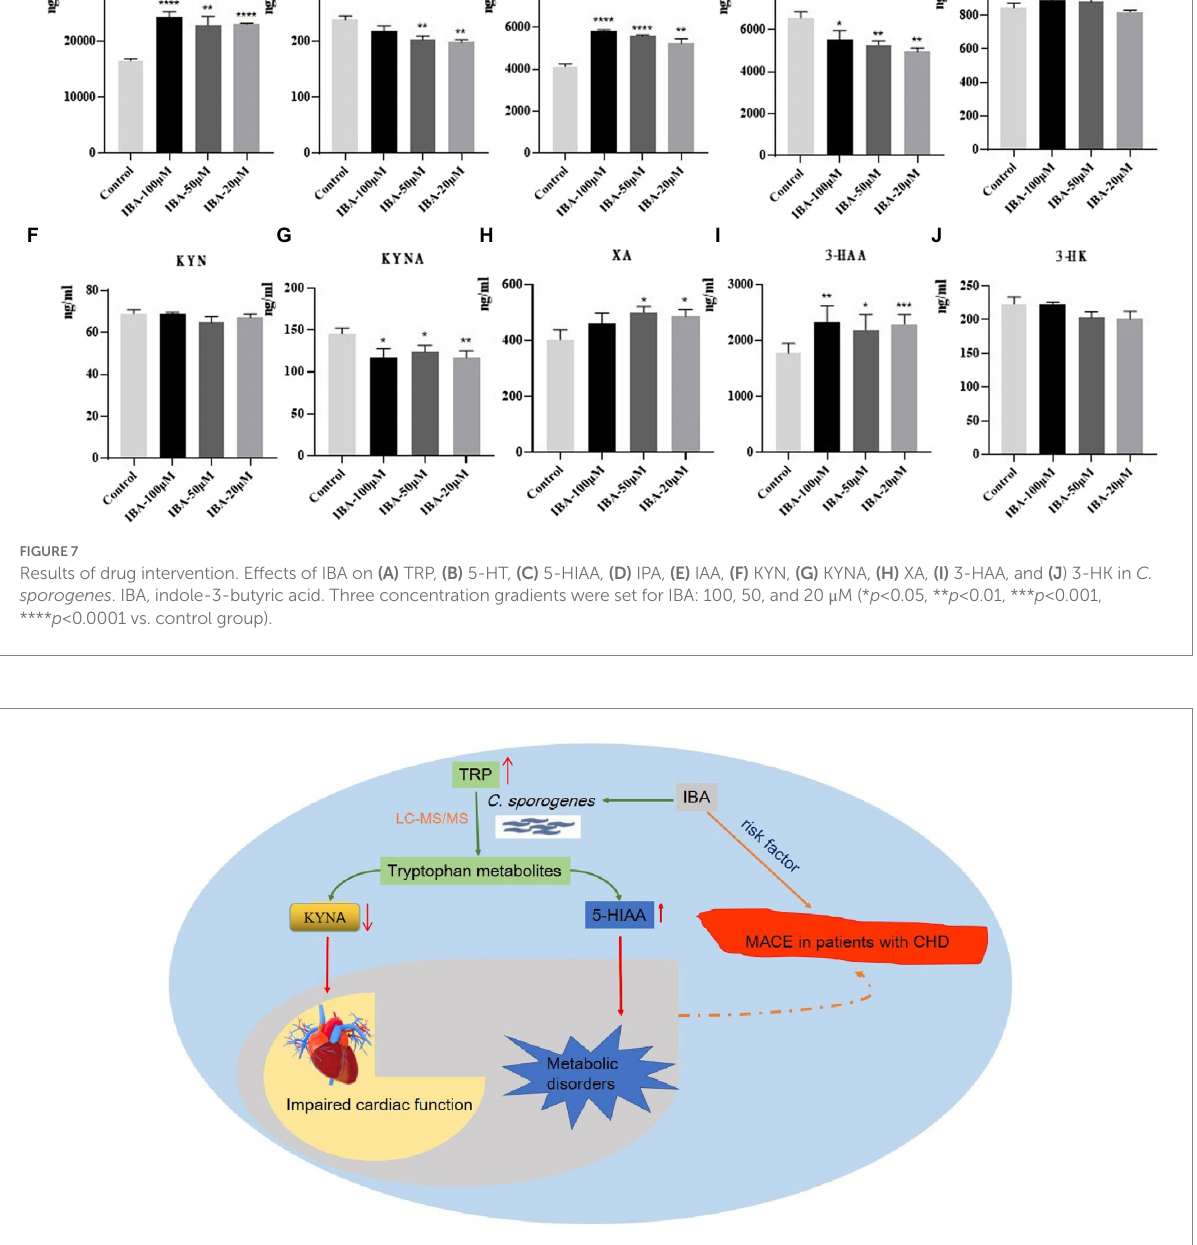
FIGURE 8 Overview of the possible mechanism of IBA affecting MACE in patients with coronary heart disease. This figure details a summary of the possible mechanism that IBA can increase the incidence of MACE in CHD patients by influencing the metabolism of TRP by C. sporogenes to produce IPA and 5-HIAA. TRP, tryptophan; IBA, indole-3-butyric acid; IPA, indole-3-propionic acid; 5-HIAA, 5-hydroxyindole-3-acetic acid; C. sporogenes , Clostridium sporogenes ; MACE, major adverse cardiovascular events; CHD, coronary heart